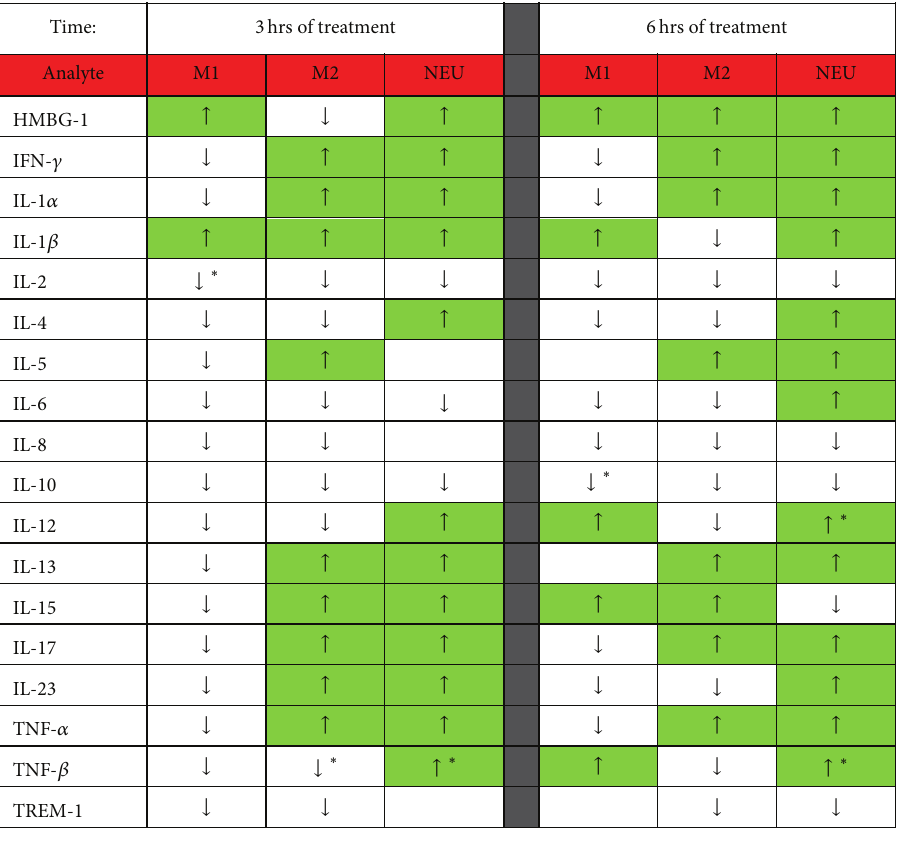
Figure 7: Inflammatory protein mediator heat map analysis of innate immune cells in response to plasma from septic swine in vitro . The production of 18 different inflammatory proteins by human M1 and M2 macrophages and neutrophils (NEU) was induced in vitro with plasma from swine taken at 3hrs and 6hrs intervals following initiation of treatment for septic injury induced at 𝑇 0 (T = NPT; C = SOC). Arrows indicate direction of response T-C. Green boxes highlight where T >